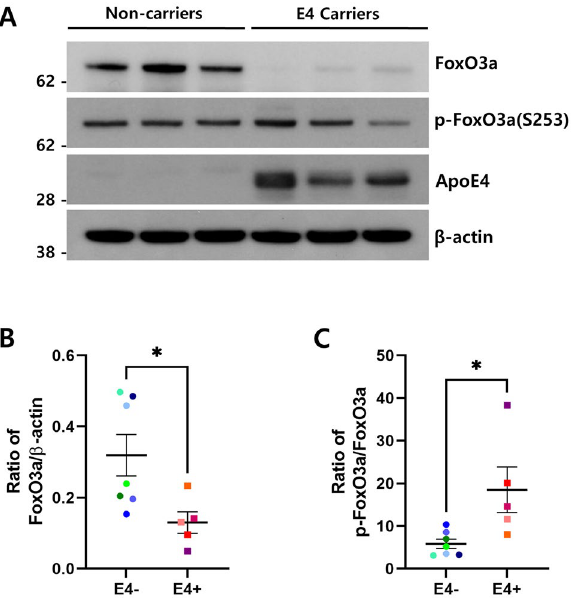
Figure 1. FoxO3a was repressed in human brains of ApoE4 carriers. Human postmortem brain tissues (superior temporal gyrus) were collected to compare ApoE4 non-carriers (n = 7, E4−) vs. carriers (n = 5, E4 +). The protein levels of FoxO3a, p-FoxO3a (Ser253), ApoE4, and β-actin were analyzed by immunoblotting using the corresponding antibodies, respectively. ( A ) shows the representative western blot analysis of FoxO3a and p-FoxO3a (Ser253). β-actin was used as a loading control. Full blots are provided in Supplementary Fig. S4. Relative ratio of FoxO3a ( B ) and p-FoxO3a (Ser253) ( C ) to the protein level of β-actin and FoxO3a,